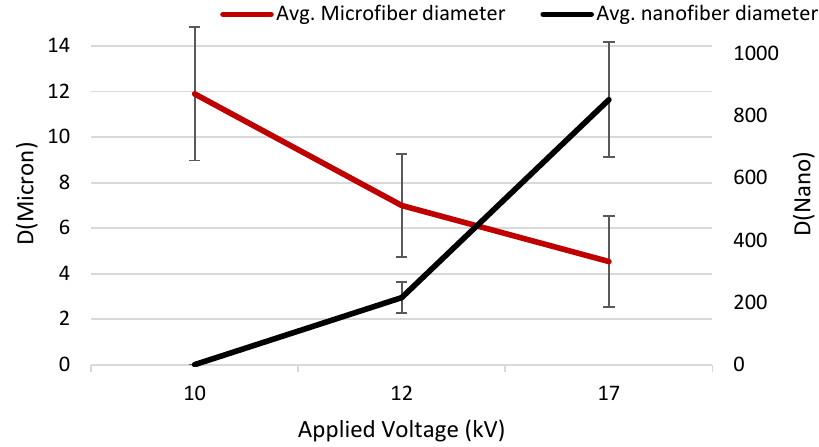
Figure 4. The effect of applied voltage on mean fiber diameter and uniformity of the fibers (standard deviation value), whereas the microfibers were formed from collagen graft copolymer and nanofibers were processed from Nylon 6 ( p < 0.005).